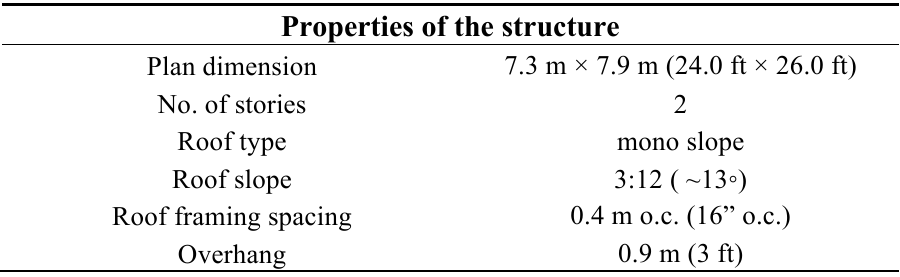
Table 1. Properties of the structure.